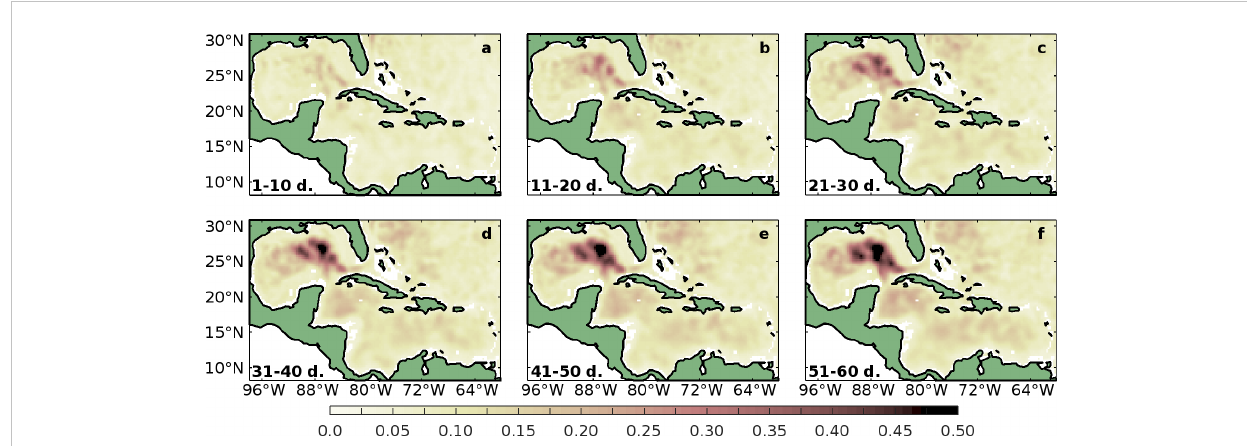
FIGURE 3 Root-mean square error in simulated Sea Surface Height (SSH, in meters) derived from the 28 forecast cycles initialized from the Ref experiment, averaged for the following forecast periods: (A) 1-10 days, (B) 11-20 days, (C) 21-30 days, (D) 31-40 days, (E) 41-50 days, and (F) 51-60